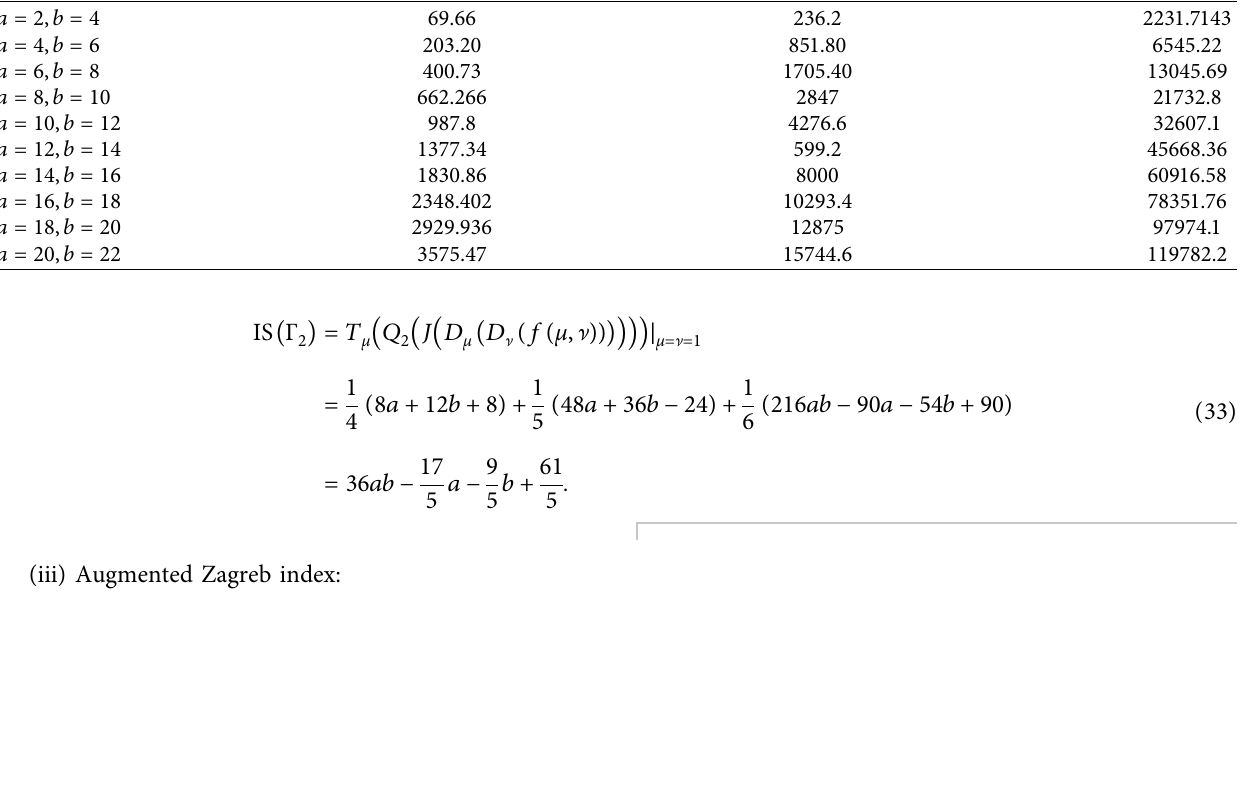
C and comparison between H ( Γ 5 7 ) , and AZI ( Γ 2